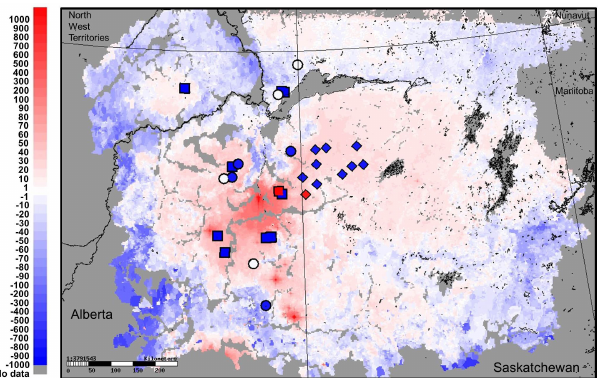
Figure 21. Comparison of predicted exceedances with model S dep corrected to match precipitation observations (Fig. 18b, units eqha − 1 yr − 1 ) with lake observation data of Hazewinkel et al. (2008) (circles), Curtis et al. (2010) (squares) and Laird et al. (2013) (diamonds). Blue symbols: sample locations showing no acidification at the current time, white symbols: locations with de- creasing pH, but within natural variability; red symbols: locations where signs of acidification were detected. Note that the colour of the symbols, which are for illustration purposes only, does not cor- respond to numerical exceedance values on the colour